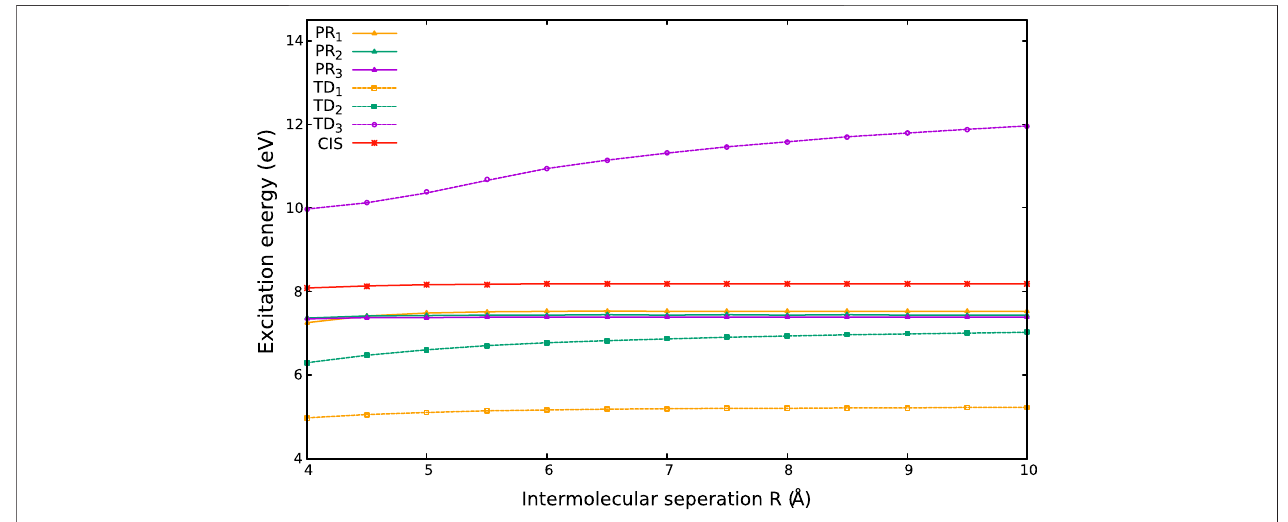
FIGURE 4 | E 0S for C 2 H 4 − C 2 F 4 versus R. PR 1 , PR 2 , and PR 3 denote the present result with BLYP, B3LYP, and LC-BLYP functional, and TD 1 , TD 2 , and TD 3 represent the same within TDDFT. Adapted from Roy et al.